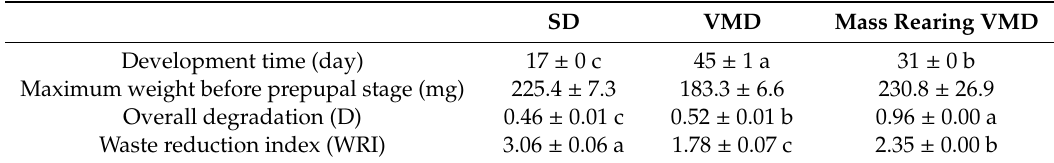
Table 1. Larval developmental time and final weight, overall degradation and waste reduction index of BSF larvae grown on different diets and conditions.